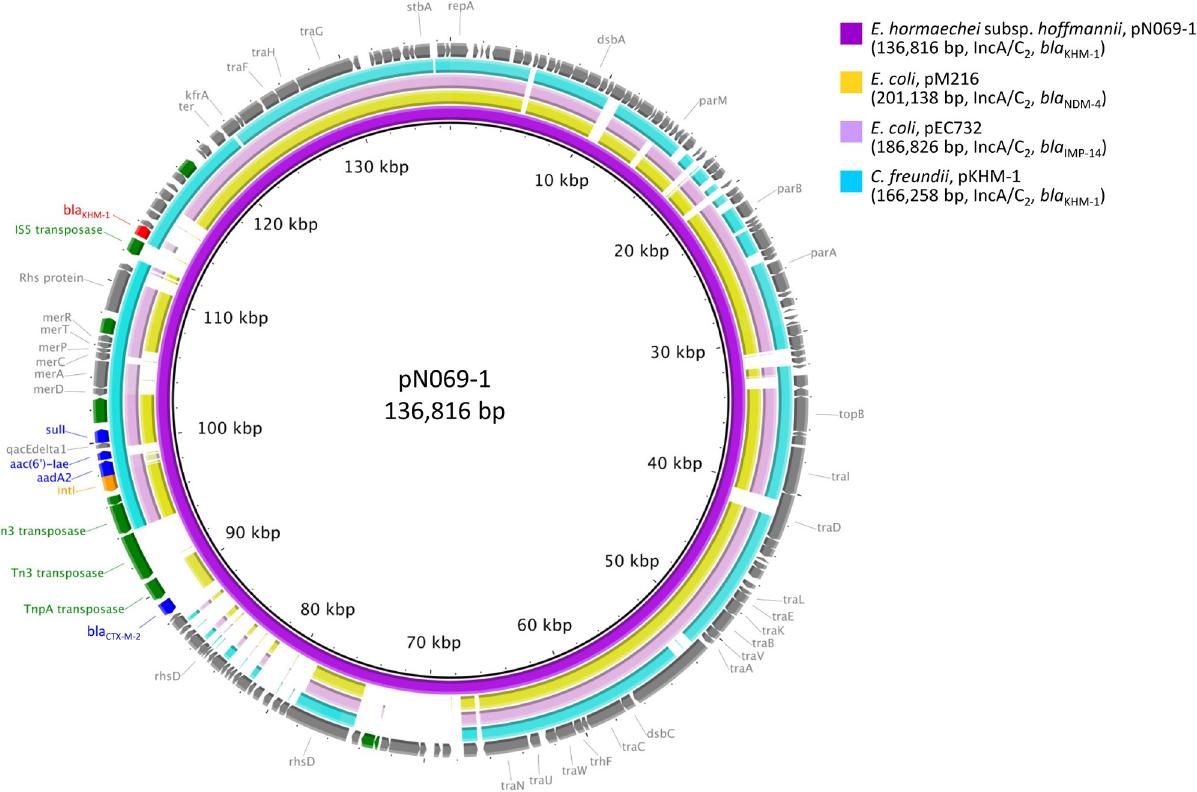
Fig 2. Circular representation of pN069-1. The comparison of pN069-1 and three plasmids; pKHM-1 from C . freundii strain KHM243 (AP014939) [4], pEC732 from E . coli (CP015139) [23] and pM216 from E . coli (AP018145) [24]. The outermost circle shows the coding sequence of pN069-1. Red, bla KHM-1 ; blue, other antimicrobial resistance genes; green, transposase and recombinase genes; orange, integrase genes; gray, other genes or coding